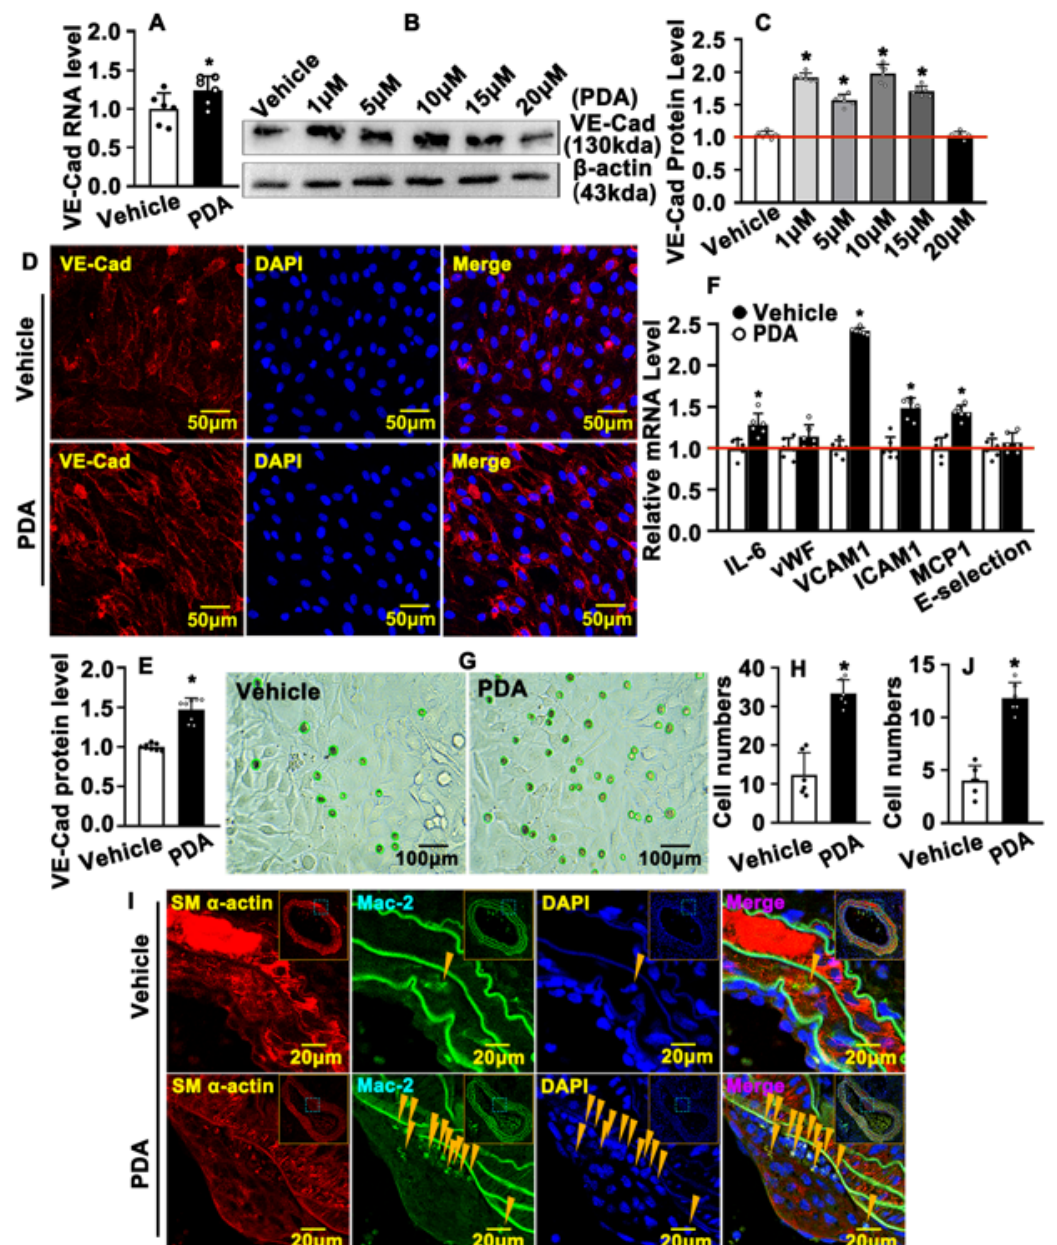
Figure 6. PDA causes VE-Cad-dependent vascular endothelial barrier dysfunction. ( A ) HUVEC-Cs were treated with PDA (10 µ M) for 12 h. Real-time PCR was performed to detect the mRNA levels of VE-Cad ( n = 6). ( B ) Western blotting was performed to determine the expression of VE-cadherin in HUVEC-Cs after PDA (10 µ M, 24 h) treatment at different doses, and the quantification data are evaluated in ( C ) ( n = 8). ( D ) IF staining of VE-Cad antibody was performed to evaluate the expression of VE-Cad in HUVECs after PDA treatment for 24 h, and the quantification data are evaluated in ( E ) ( n = 8). ( F ) HUVEC-Cs were treated with PDA (10 µ M) for 24 h. Real-time PCR was performed to detect the mRNA levels of the inflammation-related genes ( n = 6). ( G ) HUVEC-C and THP-1 were co-cultured and treated with PDA (10 µ M) for 12 h to evaluate their relationship and the changes in the process of vascular remodeling, and the quantification data are evaluated in ( H ). ( I ) IHC staining was performed against SM a-actin and Mac-2 antibodies to evaluate the level of macrophage infiltration in a left carotid artery partial ligation model following PDA treatment for 7 days. Yellow arrows indicate regions containing Mac-2–positive macrophages. The quantification data exhibited in ( J ) ( n = 8). Analytical data are expressed as means ± SEM * p <